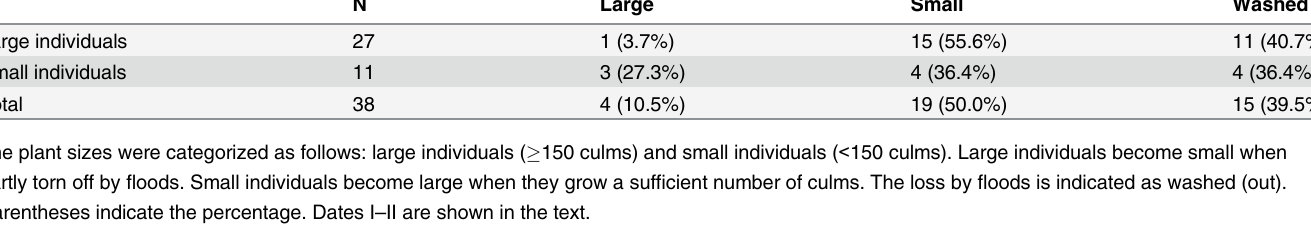
Table 2. Temporal changes with respect to individual size between Dates I – II.